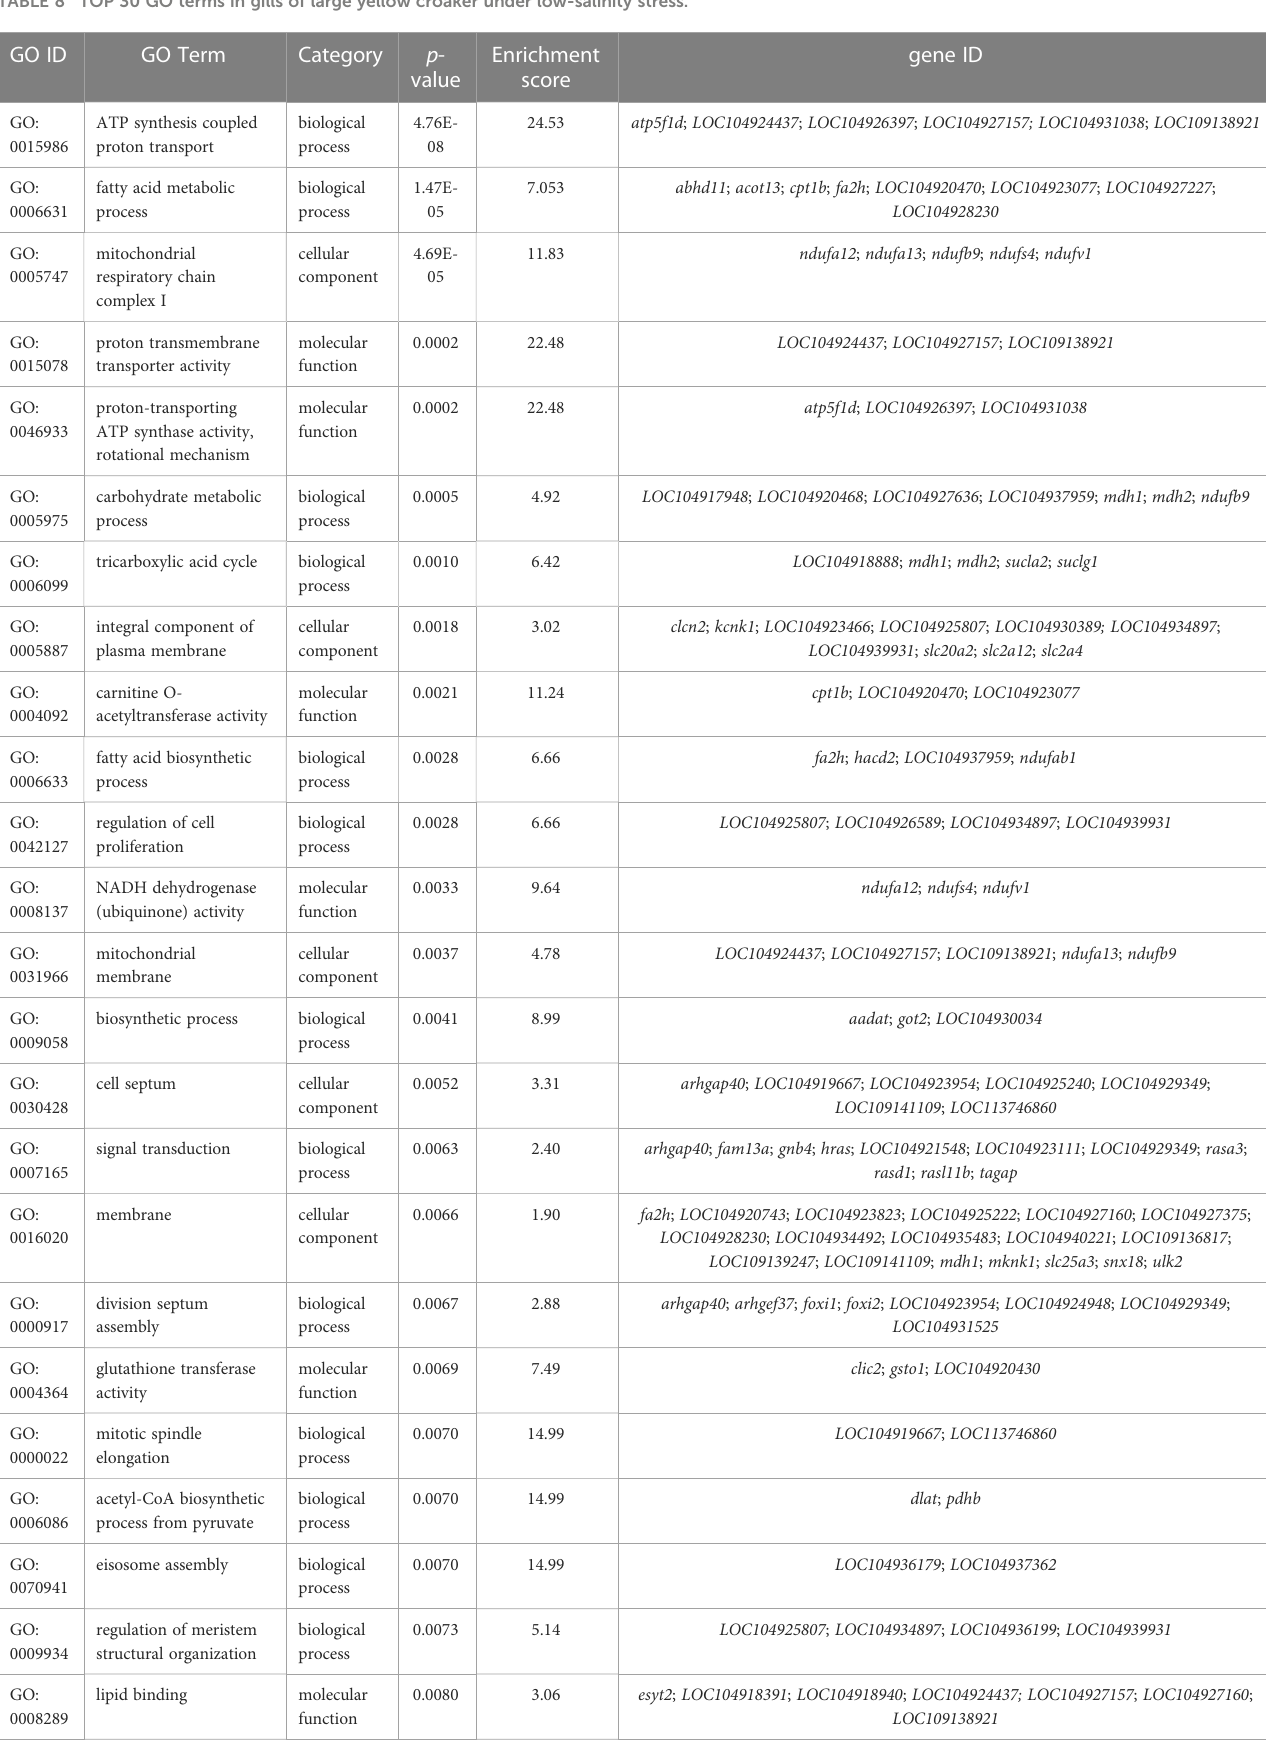
TABLE 8 TOP 30 GO terms in gills of large yellow croaker under low-salinity